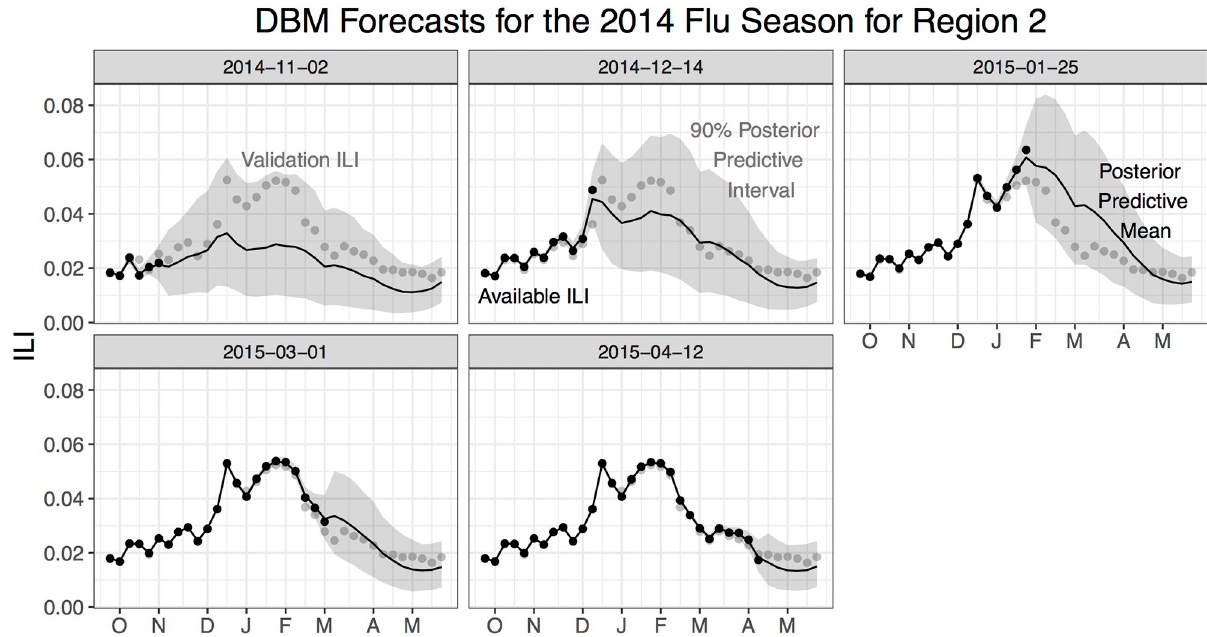
are presented, based on the jt